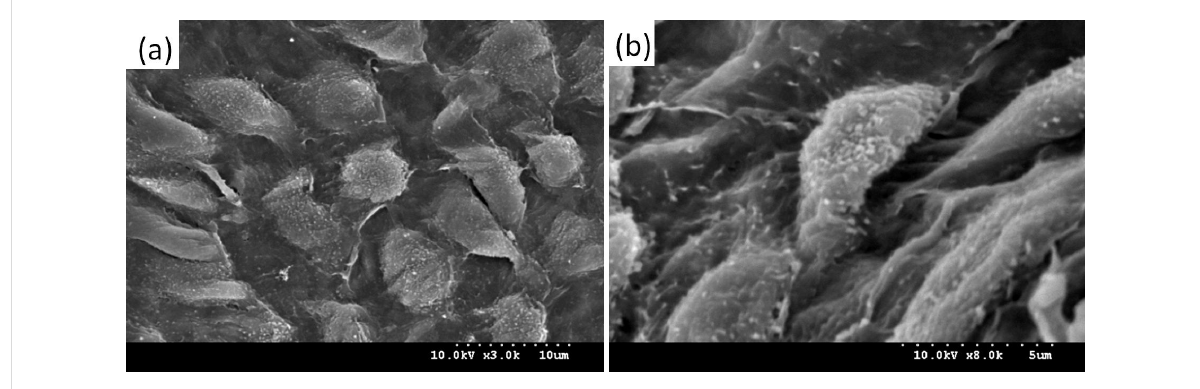
Figure 2: SEM images of the microstructure on the aortic valve cusps surface: (a) the cobblestone structure; (b) the cilia structure.